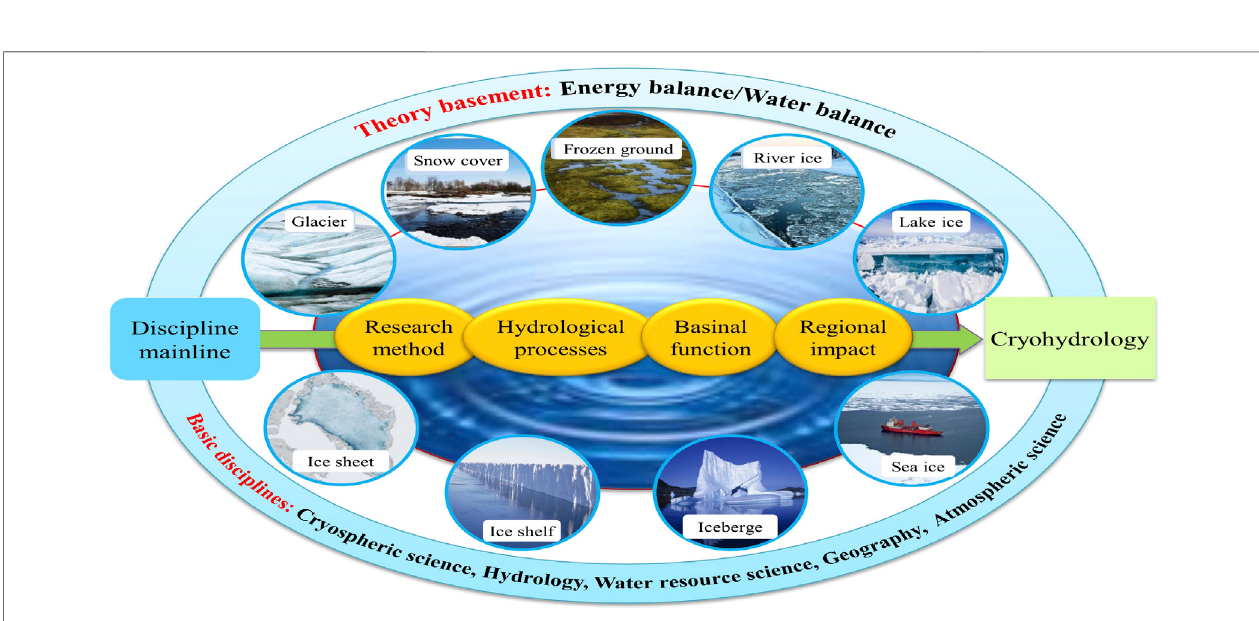
Frontiers in Earth Science |